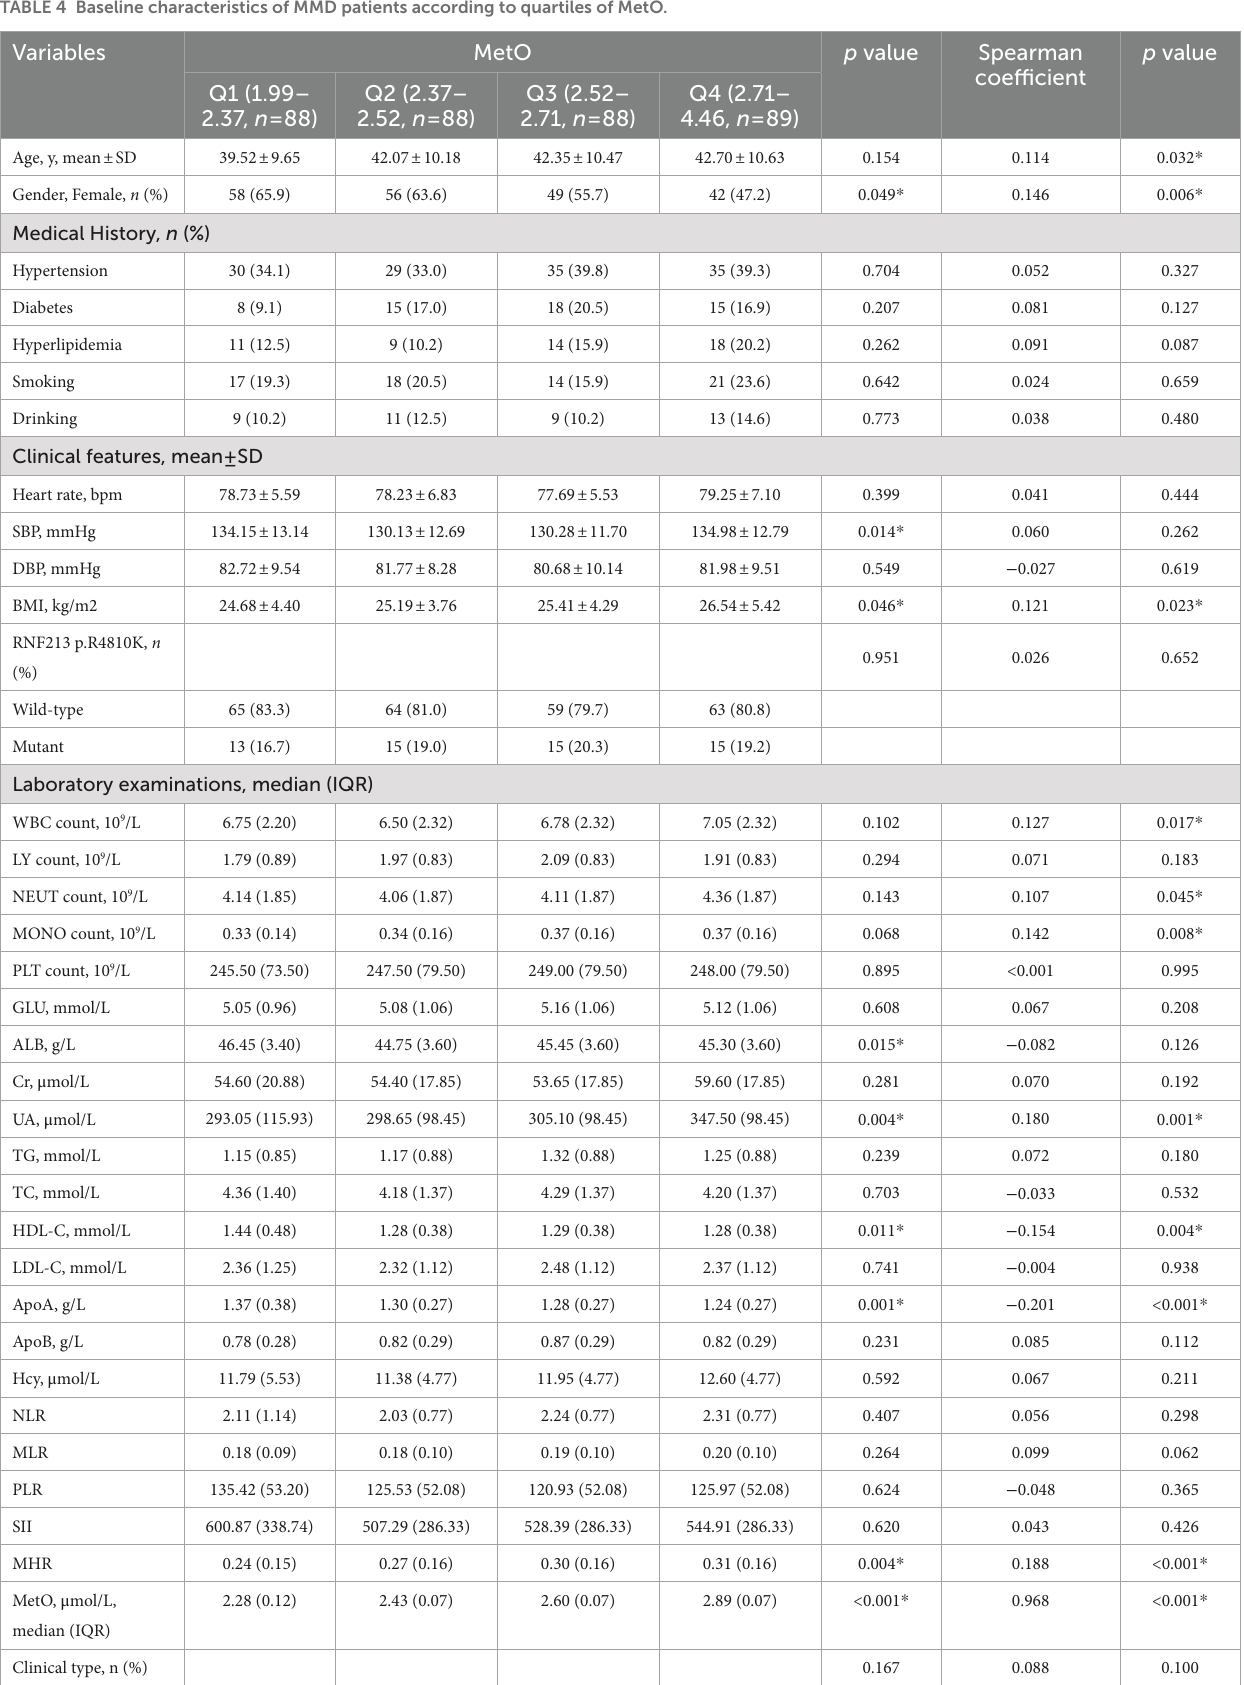
TABLE 4 Baseline characteristics of MMD patients according to quartiles of MetO. Variables